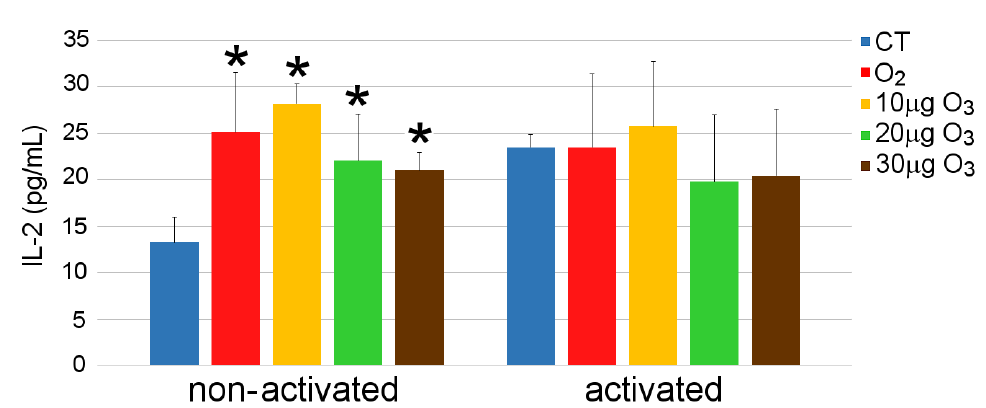
Figure 6. Diagrams show the mean value ± SD of IL-2 amount detected in the medium of non-activated and activated cell samples after 24 h from gas treatment. Asterisks (*) indicate significant difference with the respective control (CT).